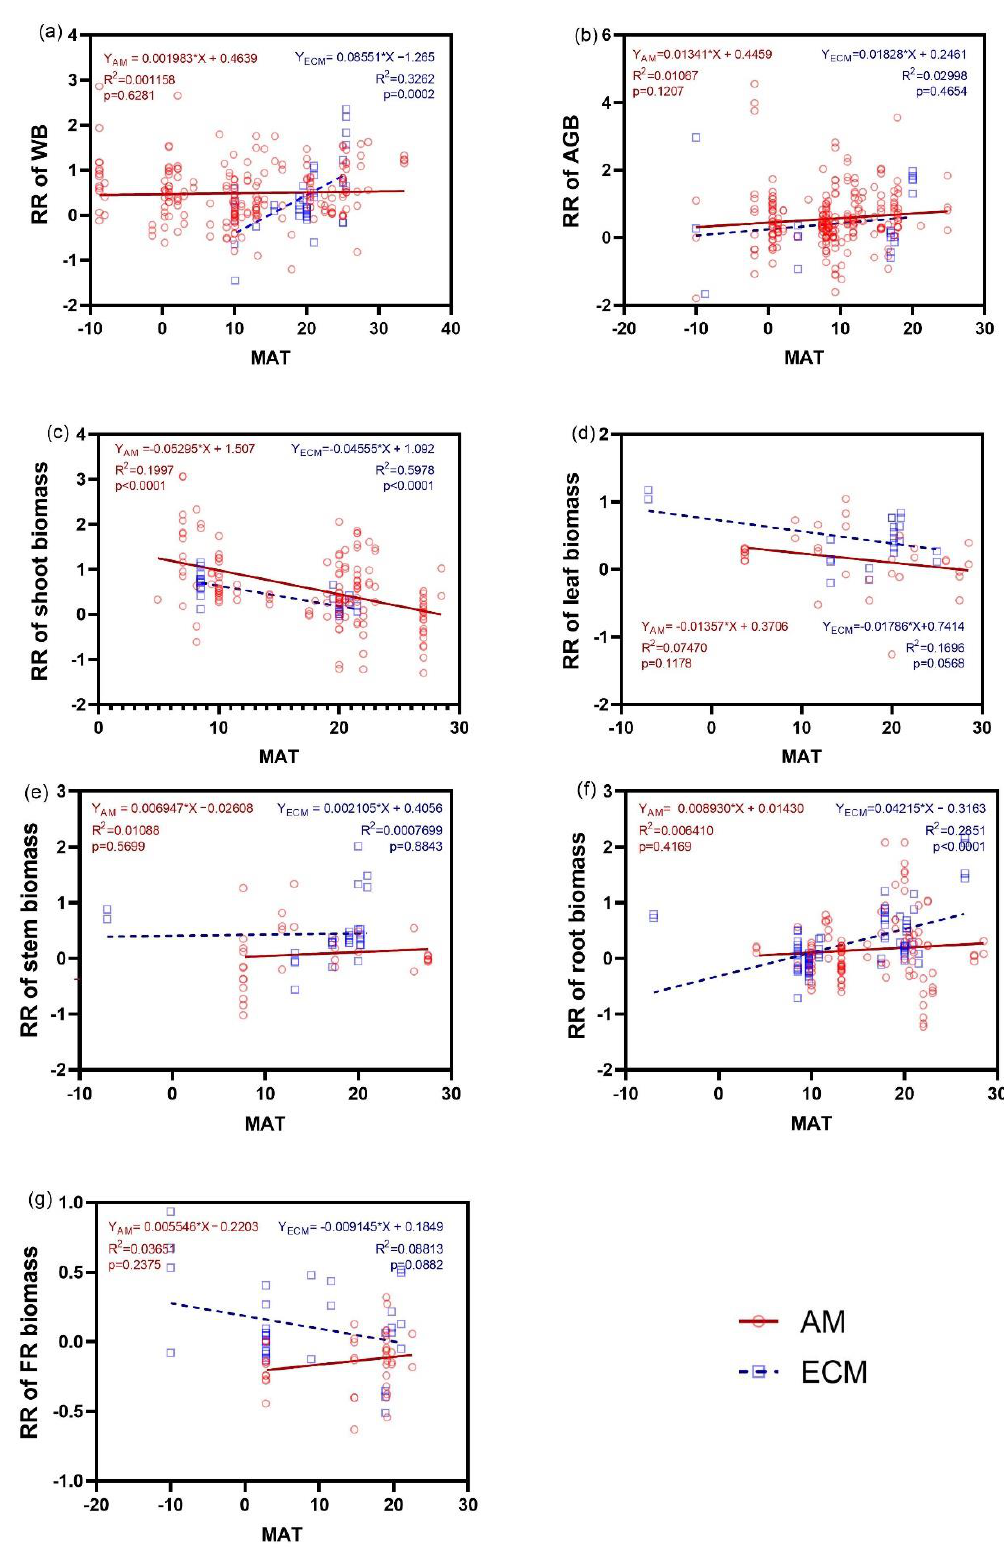
Figure 6. Relationship between the response ratio (RR) of WB ( a ), AGB ( b ), the biomass of shoot ( c ), leaf ( d ), stem ( e ), root ( f ), and FR ( g ) and changes of MAT (Mean annual temperature) under N addition between AM and ECM plants. Each point in the figure represents a different observation. AM, arbuscular mycorrhiza; ECM, ectomycorrhiza; WB, whole plant biomass; AGB, aboveground biomass; FR, fine root.